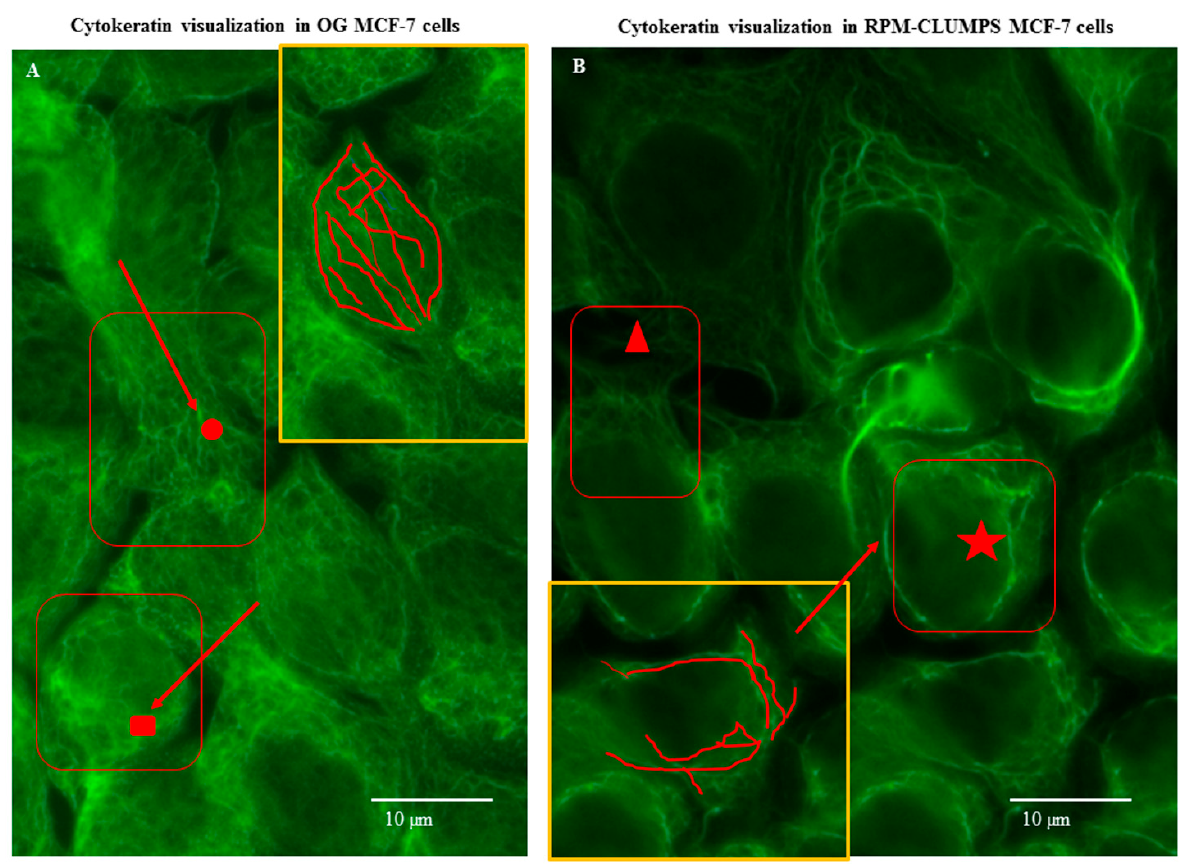
Figure 6. Confocal images of cytokeratin distribution pattern in MCF-7 cultured in normal gravitational (OG) ( A ) and microgravity (RPM-CLUMPS) ( B ) conditions for 24 h. Scale bar 10 µm. ● Desmosomes plaques at the cell–cell junction areas; ▀ perinuclear regions surrounding cell nuclei; meshes of the cytokeratin network in the perinuclear regions are looser in microgravity than in 1 g control; ▲ plaques reduced both in number and in network density. Within the yellow squares, the distribution of cytokeratins has been magnified. Red arrows indicate the relevant structures under scrutiny.